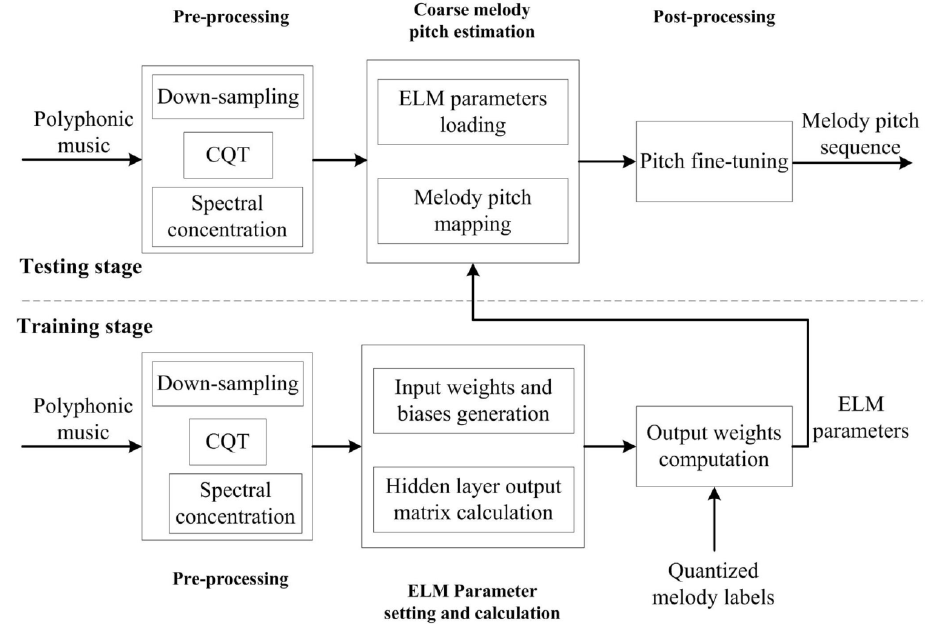
Figure 3. Block diagram of the proposed method.